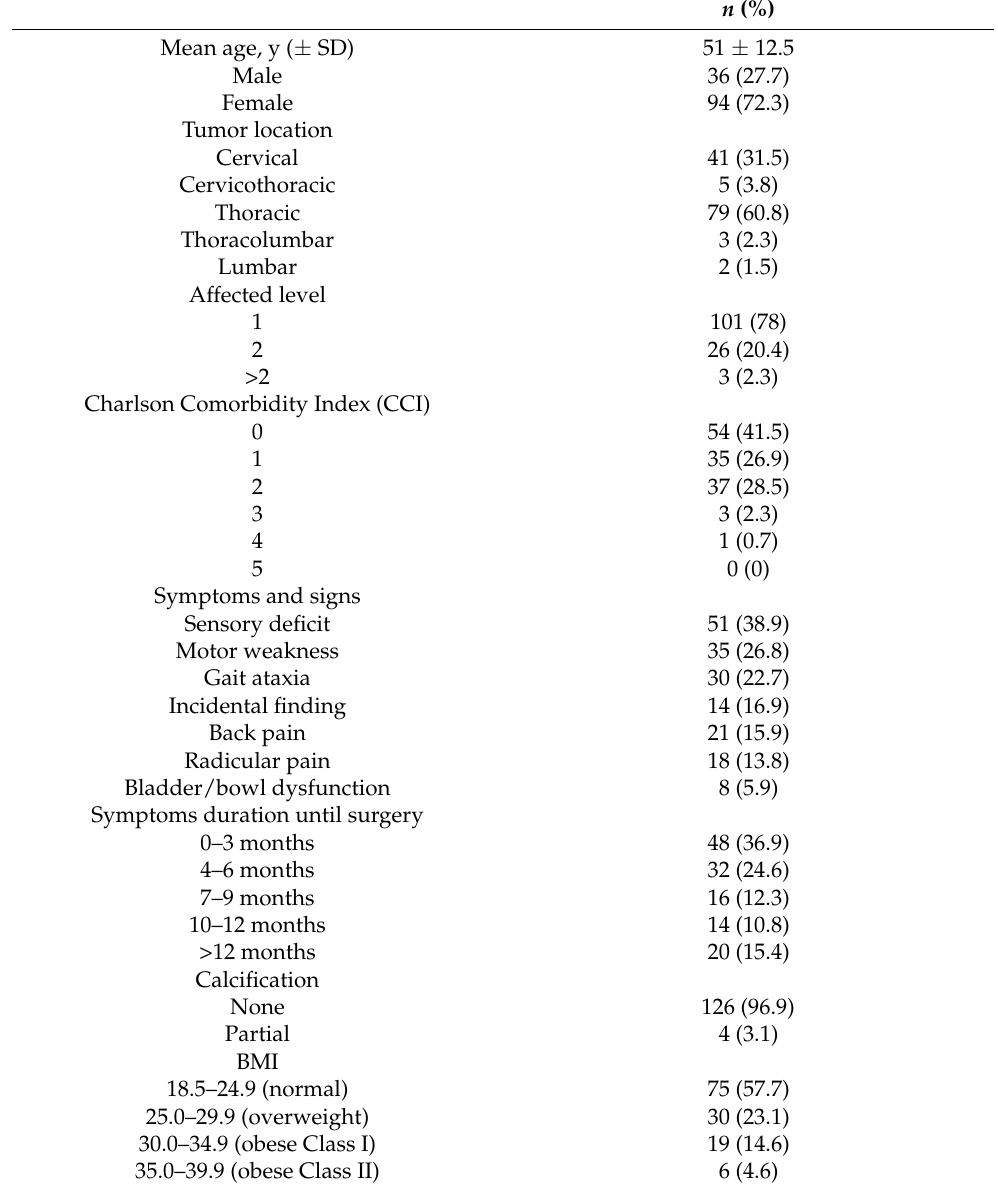
Table 1. Patient